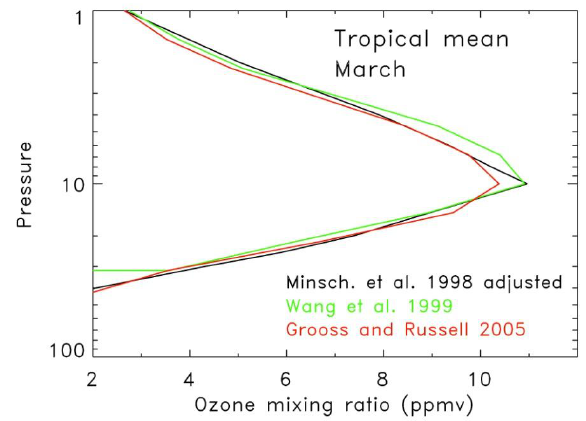
Fig. A1. Tropical ( ± 10 degree latitude mean) ozone profiles for Fig. A1. Tropical (+-10 degree latitude mean) ozone profiles for March from Minschwaner et al. 646 March from Minschwaner et al. (1998) (UARS MLS, March 1992– (1998) (UARS MLS, Mar 1992 – Jan 1993) in black, Wang et al. (1999) (UARS MLS, HALOE, 647 January 1993) in black, Wang et al. (1999) (UARS MLS, HALOE, and SAGE II, Apr 1992 Mar 1993) in green, and Grooβ and Russell (2005) (UARS HALOE 648 and SAGE II, April 1992 March 1993) in green, and Grooß and Rus- 1991-2002) in red. The profiles from Minschwaner et al. (1998) have been reduced by a constant 649 sell (2005) (UARS HALOE 1991–2002) in red. The profiles from 3% to compensate for an overall positive bias with respect to the other data sets. 650 Minschwaner et al. (1998) have been reduced by a constant 3% to compensate for an overall positive bias with respect to the other